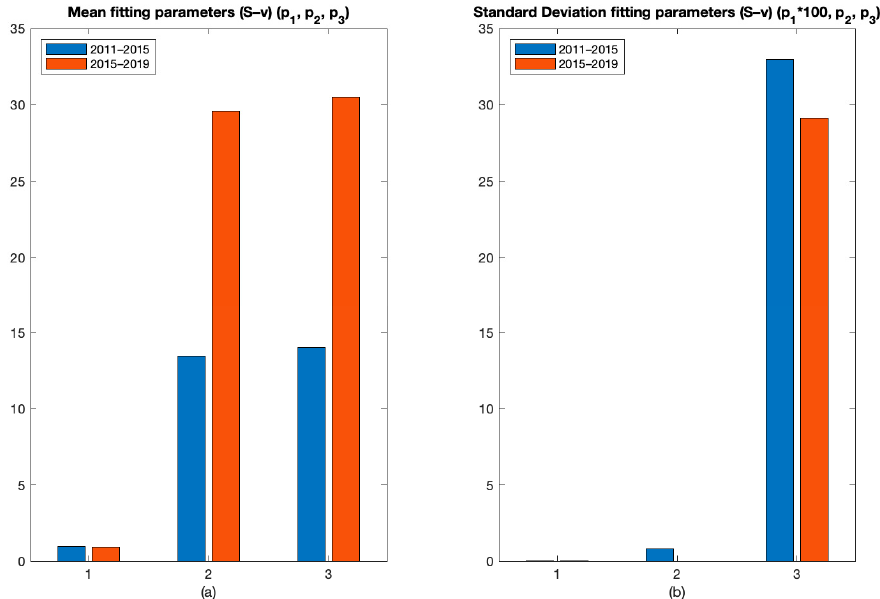
Figure 14. Fitting parameters of the entropy-velocity dispersions in the two periods for a building complex near San Giovanni station: ( a ) parameters of the mean model; ( b ) parameters of the standard deviation model.